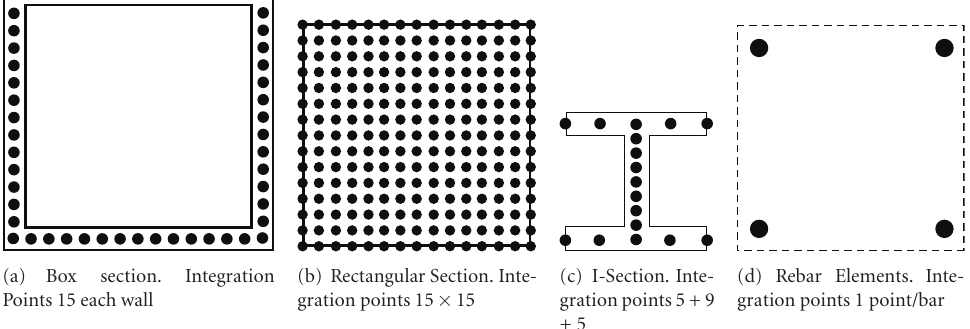
Figure 3: Location of integration points used for FEM of cross-section.